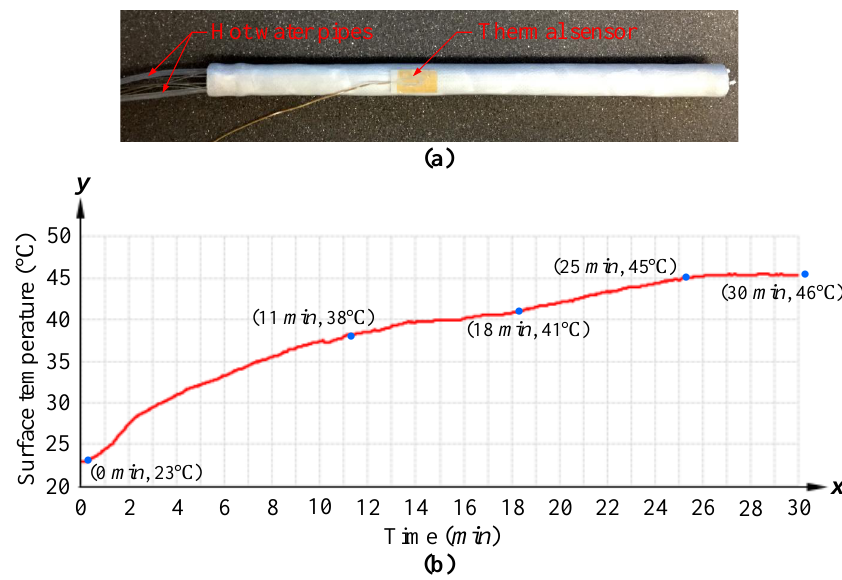
Figure 9. Surface temperature test for our proposed variable stiffness endoscopic manipulator: ( a ) established experimental setup, where the fabricated prototype of the manipulator had a thermal sensor for recording surface temperature and was connected with two pipes for hot water (65 ◦ C) supply and discharge; ( b ) endoscopic manipulator surface temperature change recorded from beginning of heat supply to reaching thermal